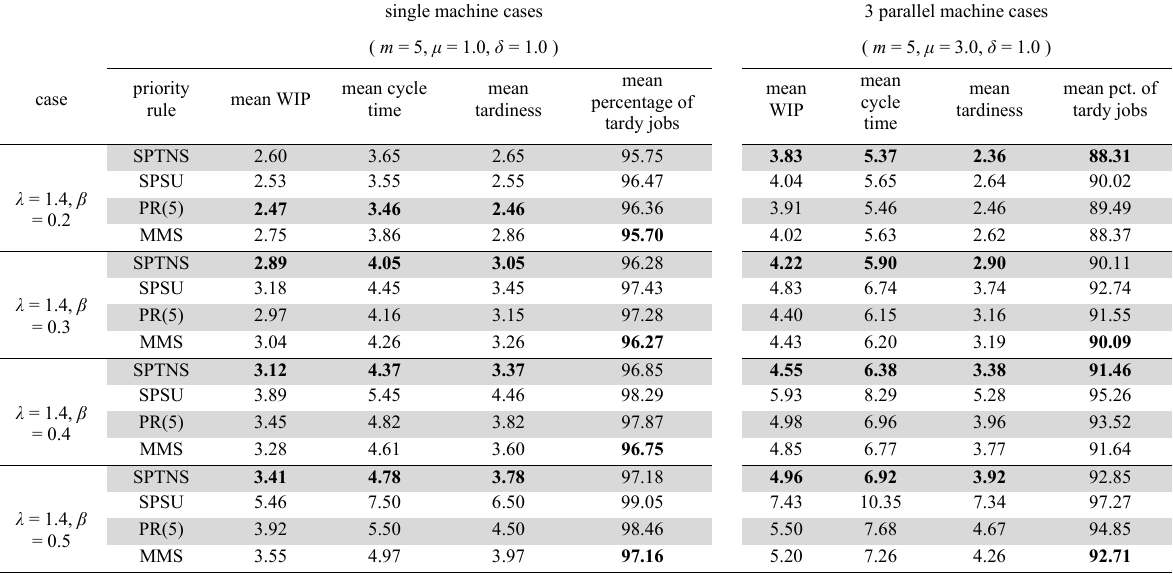
Comparison between SPSU, SPTNS, MMS and PR (continued from Table 10). The minimum values for each performance metric and simulation case are denoted in